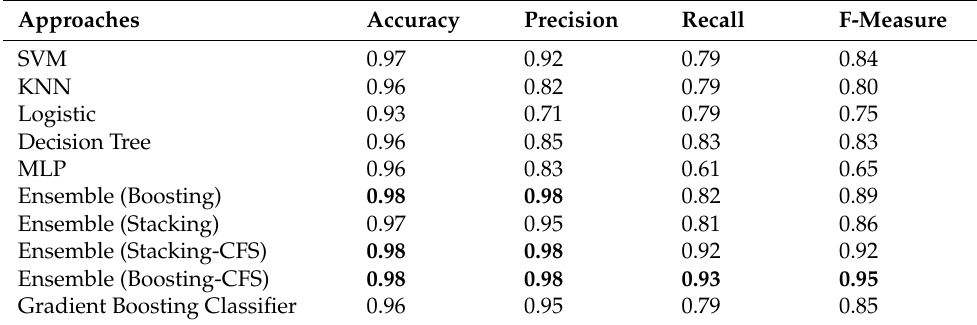
Table 2. Classification